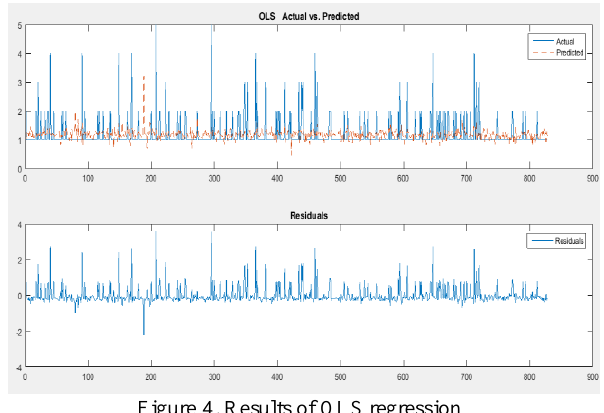
Figure 4. Results of OLS regression